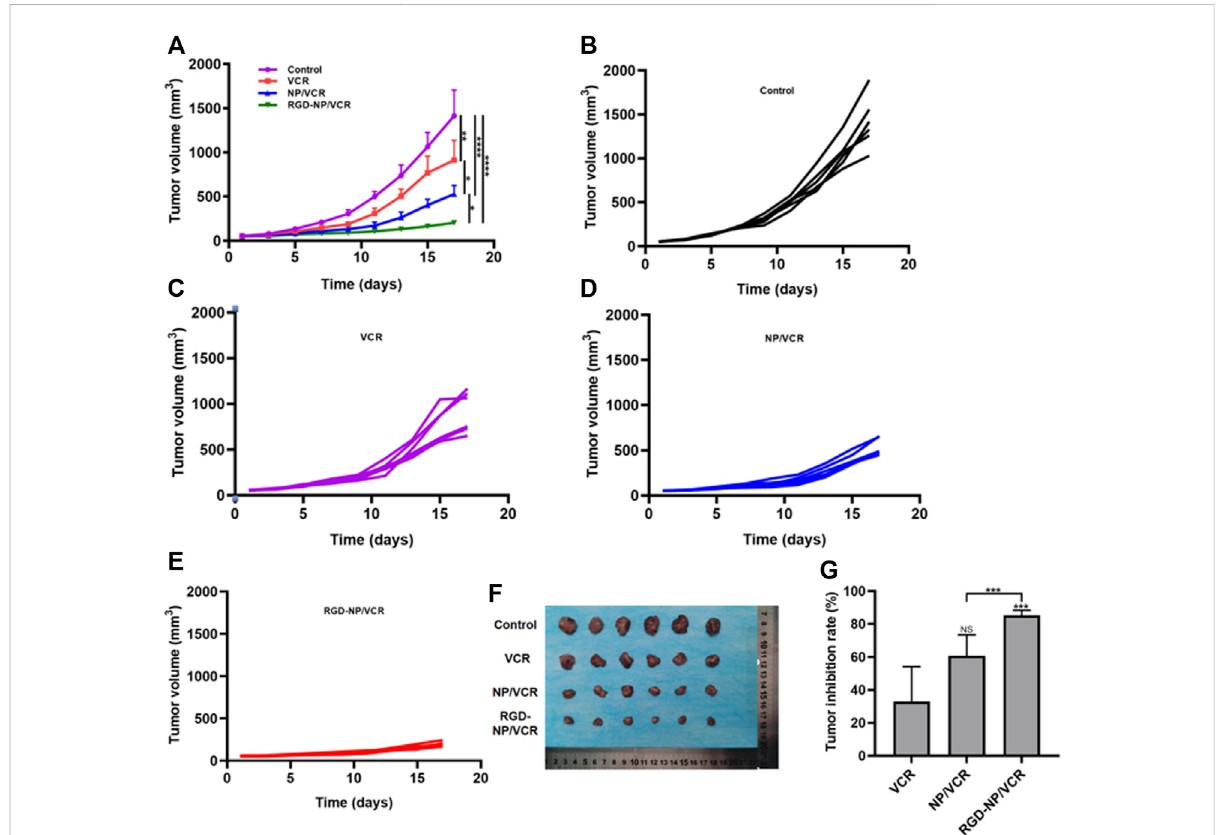
FIGURE 4 (A) The change in tumor volume of Control, VCR, NP/VCR, and RGD-NP/VCR group; (B – E) The change in tumor volume of per mouse in Control, VCR, NP/VCR, and RGD-NP/VCR group; (F) The tumor volume at the end of treatment; (G) The tumor inhibition rate of VCR, NP/VCR and RGD-NP/VCRgroup.Thedataineachgroupisshowedbymean±SD( n =6,NS:Nosigni fi cance,* p < 0.05,** p < 0.01,*** p < 0.001,**** p <